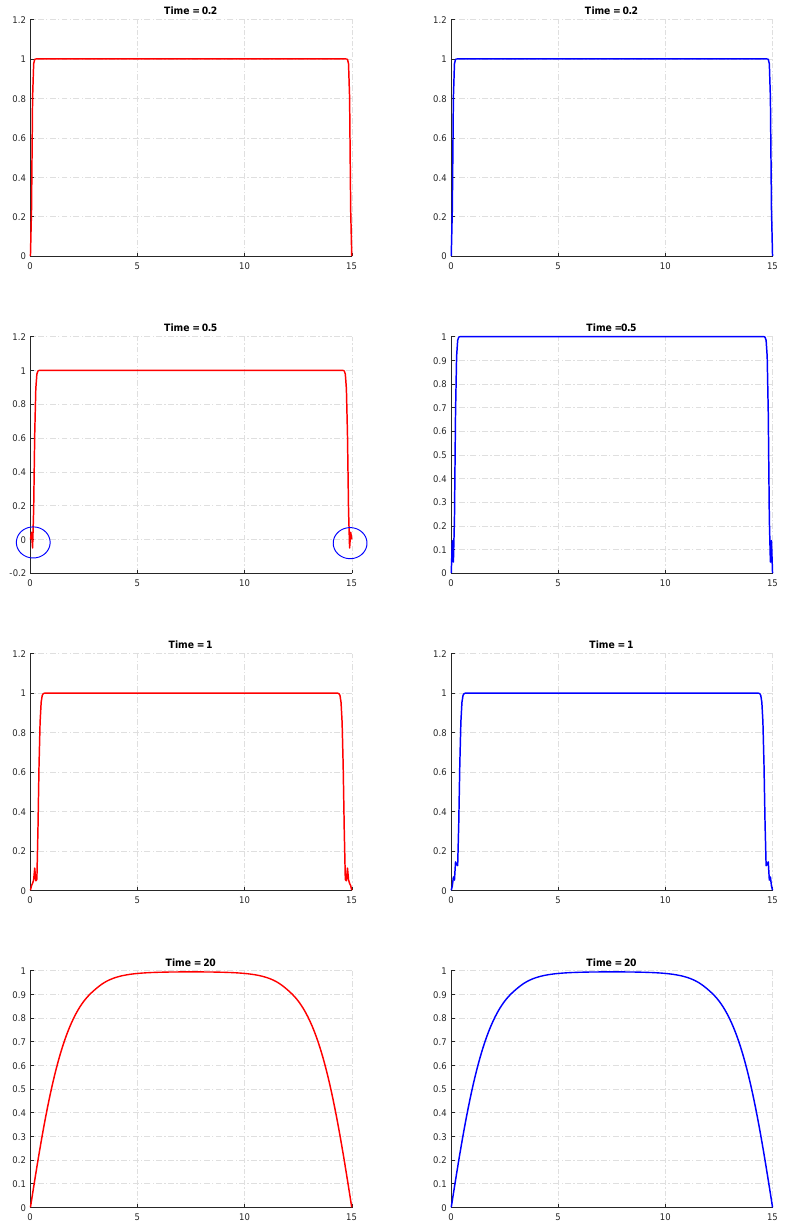
Figure 4. Solution of the reaction–telegraph equation with the logistic growth without cutoff ( left , red curves) and with the cutoff of negative values ( right , blue curves). Parameters are ω 1 = 6 and ω 2 = 2. The circles mark the location of the areas where the solution becomes